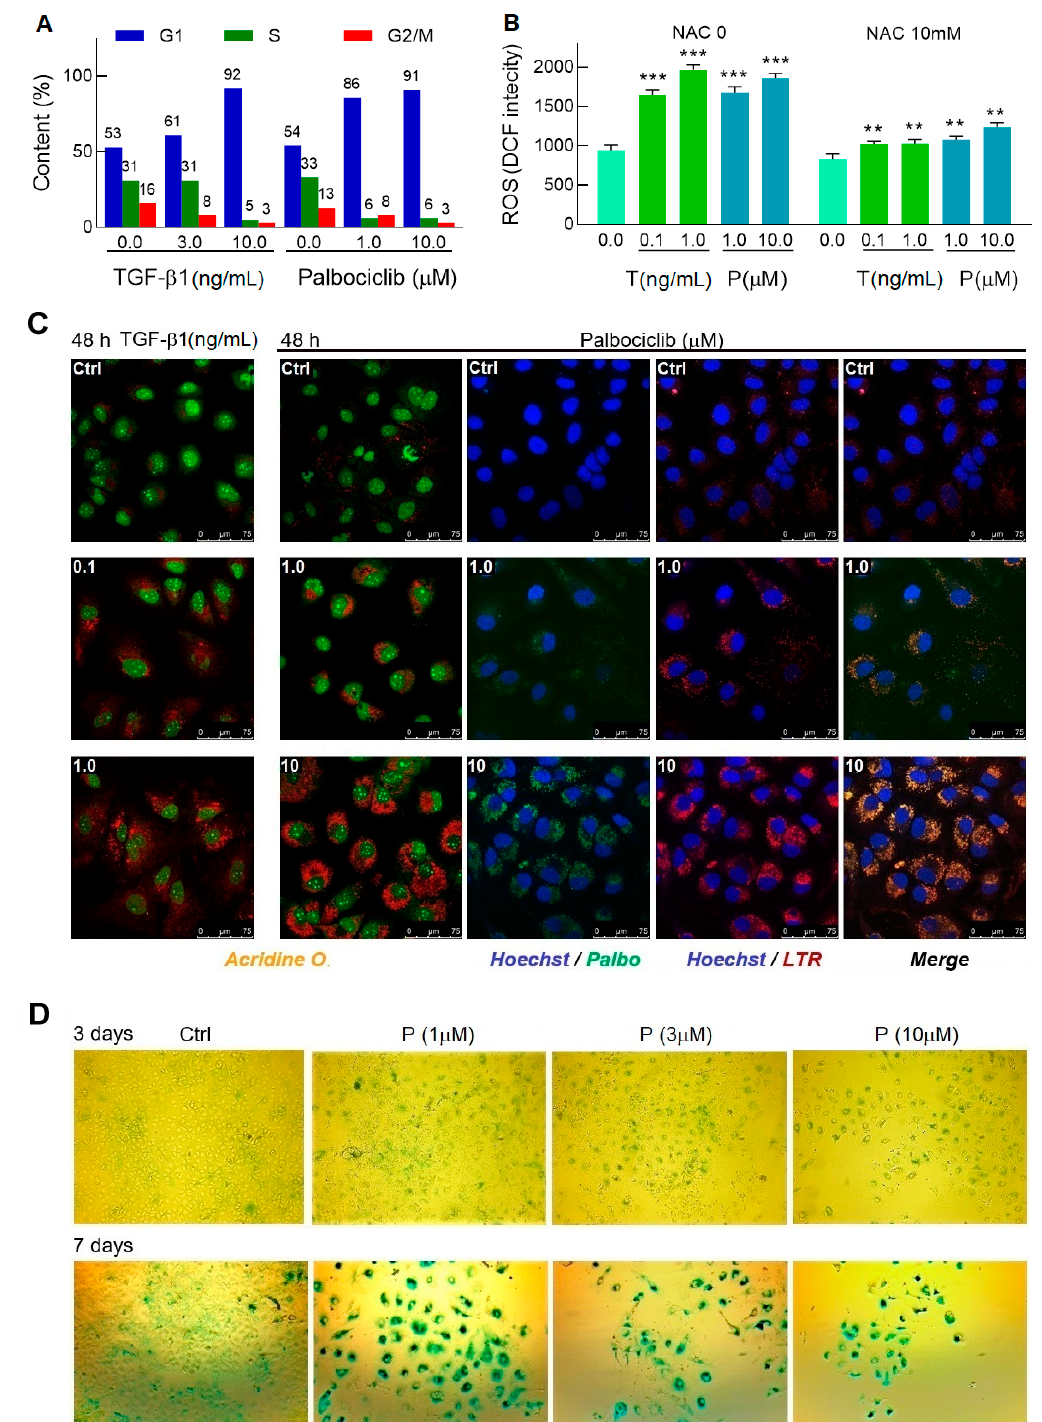
Figure 2. TGF- β 1 and palbociclib launch the senescence program in Huh7-luc/neo cells. ( A ) Cells were treated with indicated concentrations of TGF- β 1 and palbociclib for 48 h and 24 h, respectively, and analyzed for cell cycle distribution by flow cytometry. ( B ) 24 h of incubation with TGF- β 1 and palbociclib induced oxidative stress that was manifested in ROS production detected by fluorometry of cells stained with DCF-DA ( n = 5). ( C ) Confocal microscope images of Acridine Orange -stained cells treated with indicated concentrations of TGF- β 1 and palbociclib (shown in the upper left corner) and colocalization of intrinsic fluorescence of LTR and palbociclib. ( D ) Light microscope images ( × 10 magnification) of X-Gal - stained cells treated with palbociclib for 3 and 7 days. Blue-green indicates positive staining for β -galactosidase activity; n is the number of independent experiments. Statistical significance (assessed by the t -test): *** ( p < 0.001), ** (0.001 < p <